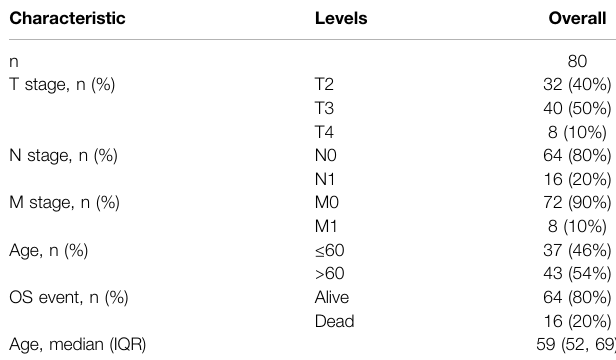
TABLE 2 | Basic clinical characteristics of PRAD patients in validation cohort. Characteristic